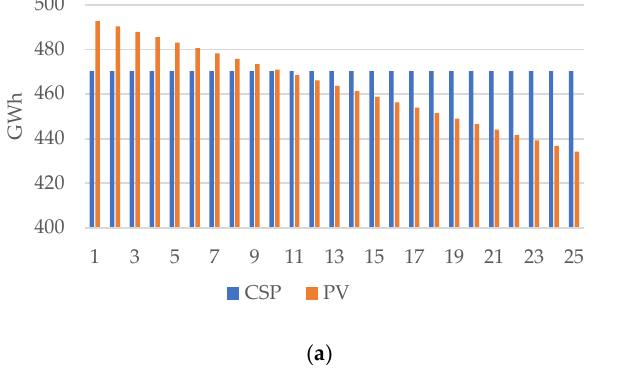
Figure 5. ( a ) Annual electricity net generation of CSP and PV plants, ( b ) total electricity net generation comparison between the CSP and PV plants in 25 years of lifetime.